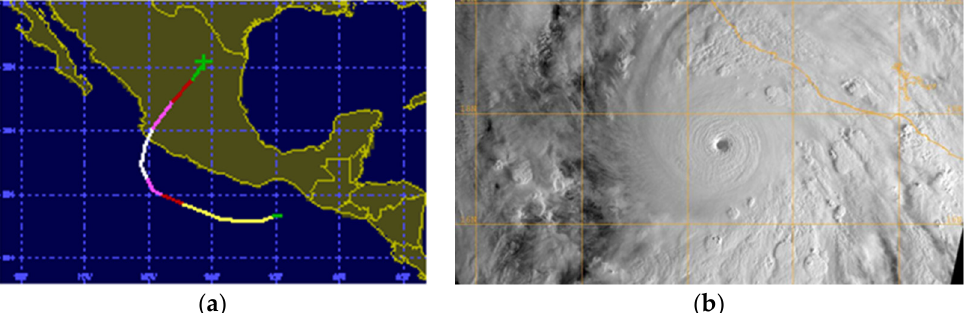
Figure 3. The ( a ) track of Hurricane Patricia (see: [32] ); and ( b ) a visible satellite image near the time of maximum intensity at 1500 UTC 23 October 2015.